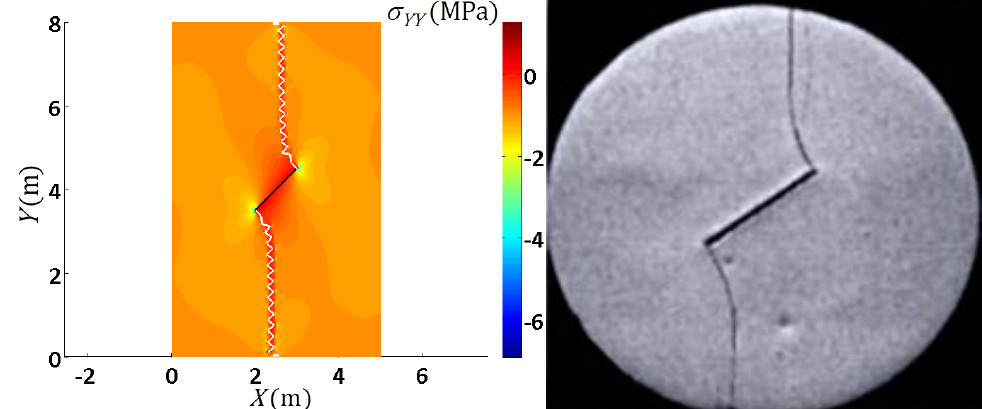
Figure 8. 45 degrees slanted center crack propagation. Numerical (left) and experimental results (right)